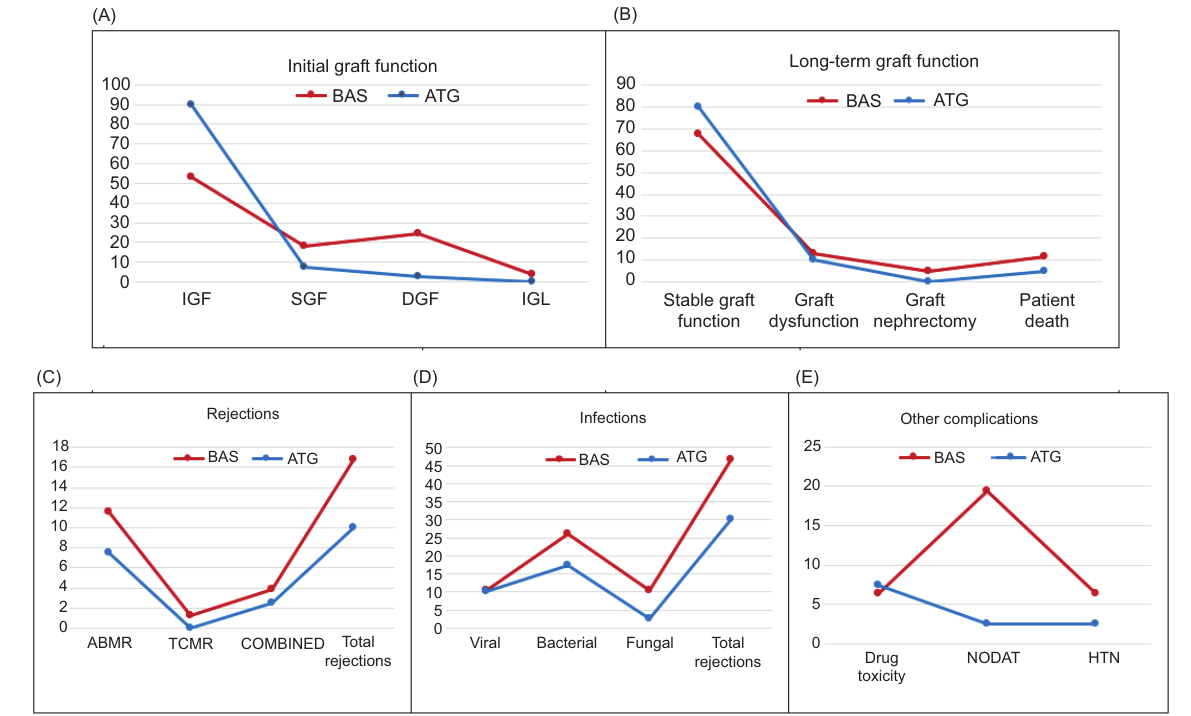
Figure 1: Induction therapy with respect to (A) Initial graft function; (B) long-term graft function; (C) rejections; (D) infections; and (E) other